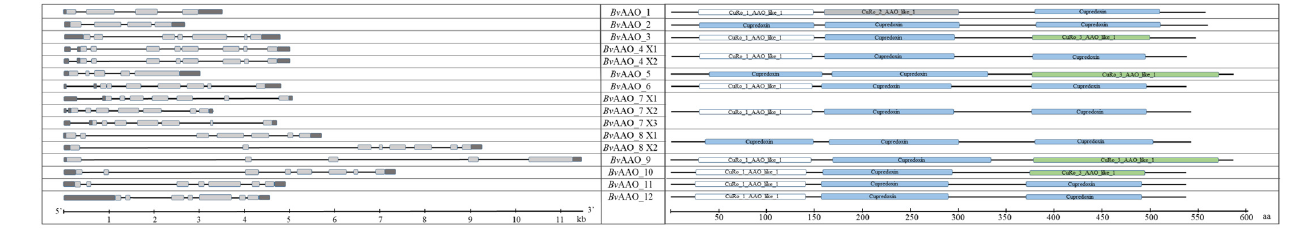
Figure 2. Exon − intron structure ( left side) and conserved protein domain family ( right side) of AAO genes in Beta vulgaris . UTRs − dark gray rectangles, exons − light gray rectangles, introns − black lines, the first cupredoxin domain of plant ascorbate oxidase homologs − white rectangles, the second cupredoxin domain of plant ascorbate oxidase homologs − gray rectangle, the third cupredoxin domain of plant ascorbate oxidase homologs − green rectangles, cupredoxin superfamily domain − blue rectangles.